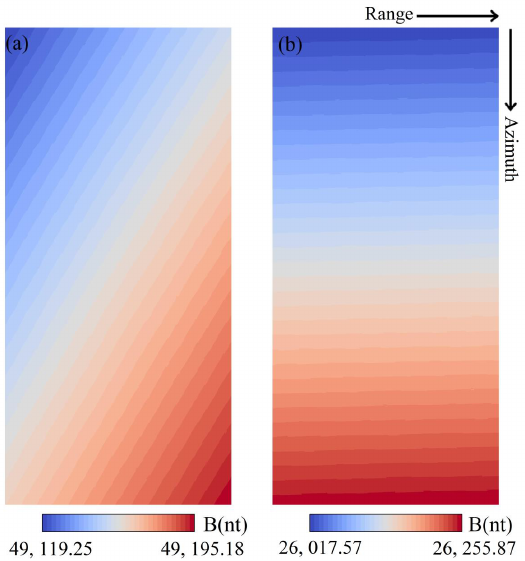
Figure 5. The intensity of the Earth's magnetic field for two interferometric pairs: ( a ) The Alaska case, ( b ) the Equator case.